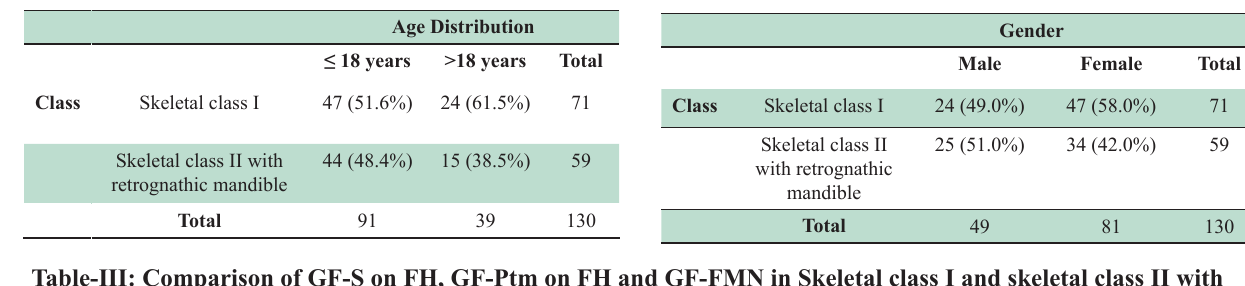
Table-I: Distribution of age in both skeletal classes. Table-II: Distribution of gender in both skeletal